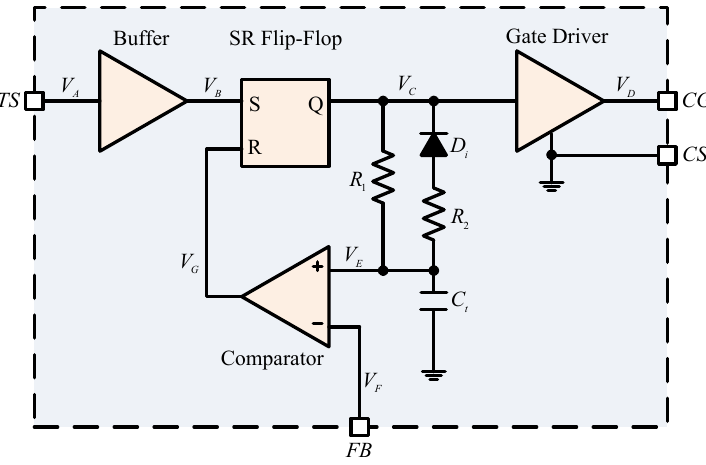
Figure 20. Block diagram of auxiliary control circuit.